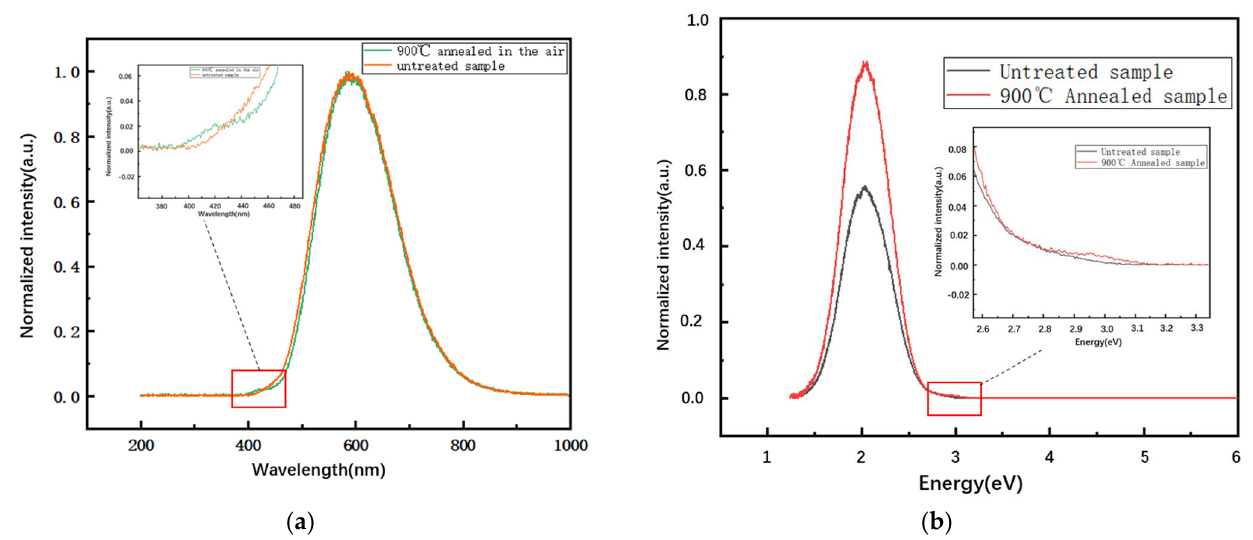
Figure 5. Comparison of measurement results of untreated samples and samples annealed at 900 °C with the same fl uence of 1.45 × 10 11 ions/cm2 at 100 K. ( a ) Wavelength spectrum; ( b ) energy spec-